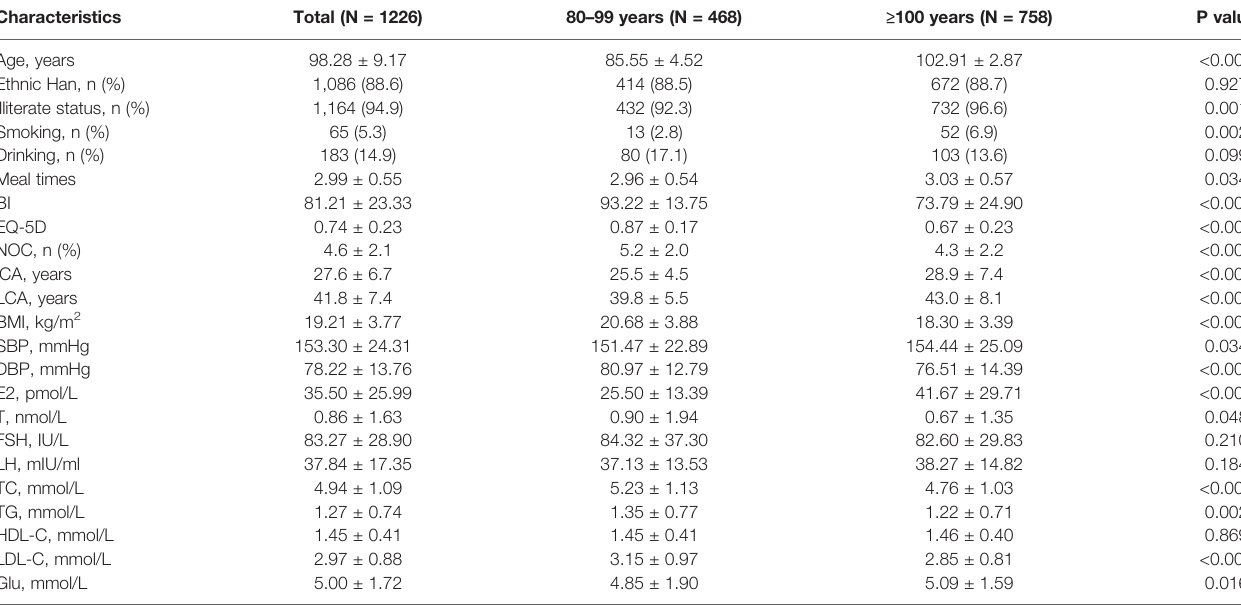
TABLE 1 | Characteristics of oldest-old population aged 80 – 99 years and ≥ 100 years.